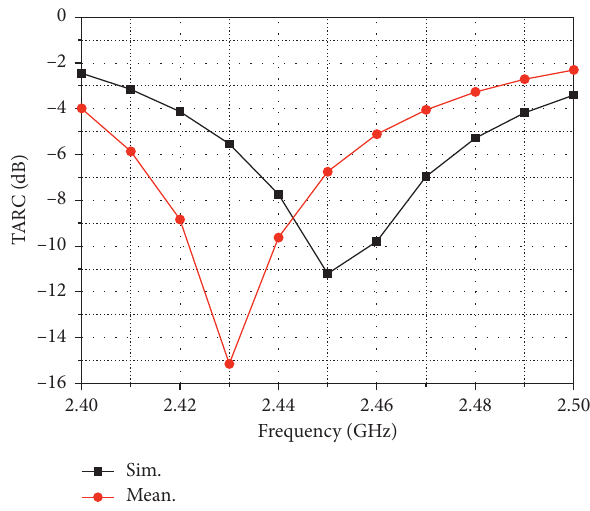
Figure 16: Simulated and measured TARC of the proposed